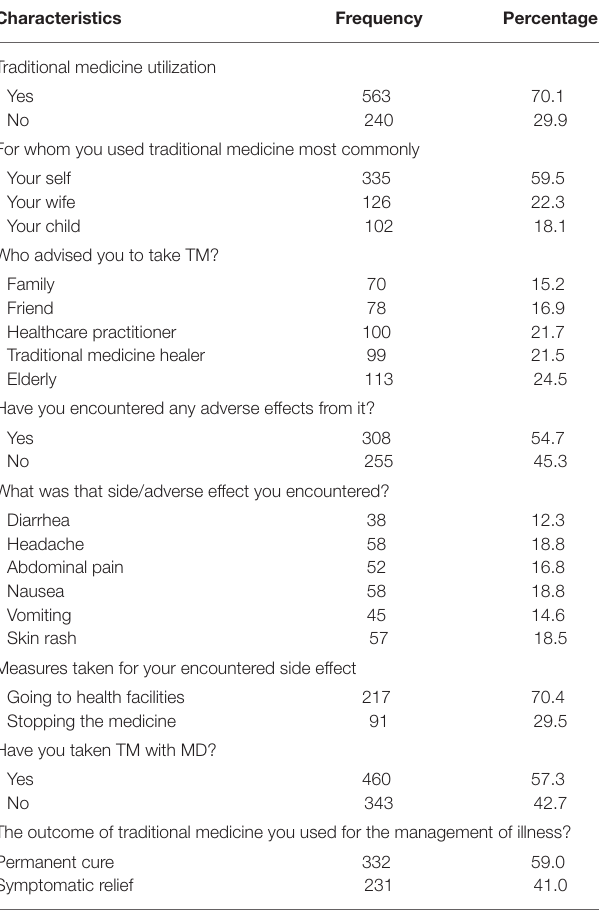
TABLE 1 | Socio-demographics characteristics of the participants in Harari region, Easter Ethiopia, 2022 ( n = 803).